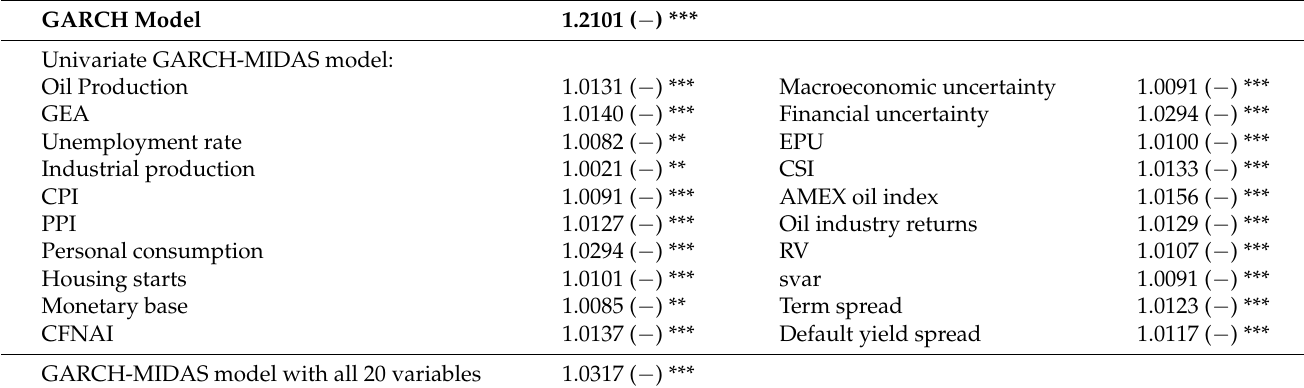
Table 4. Out-of-sample prediction